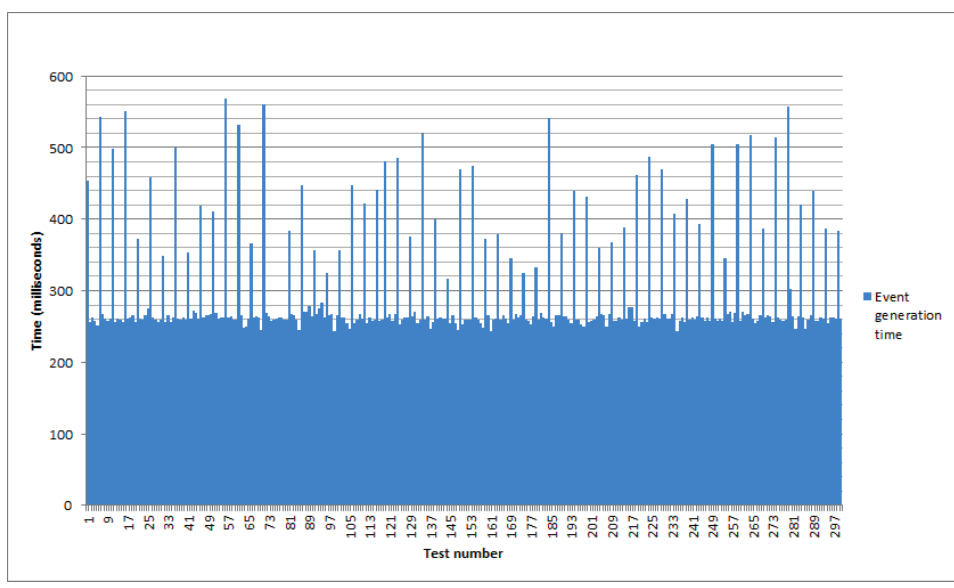
Figure 8. Time to generate an event.